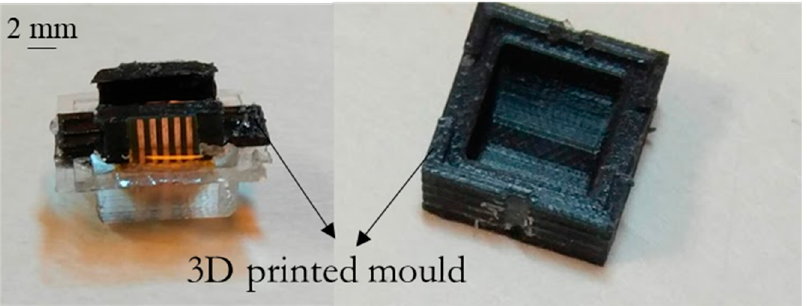
Figure 6. Two-part 3D printed mold used to shape the elastomeric part and conform the FPC with the Si chips.